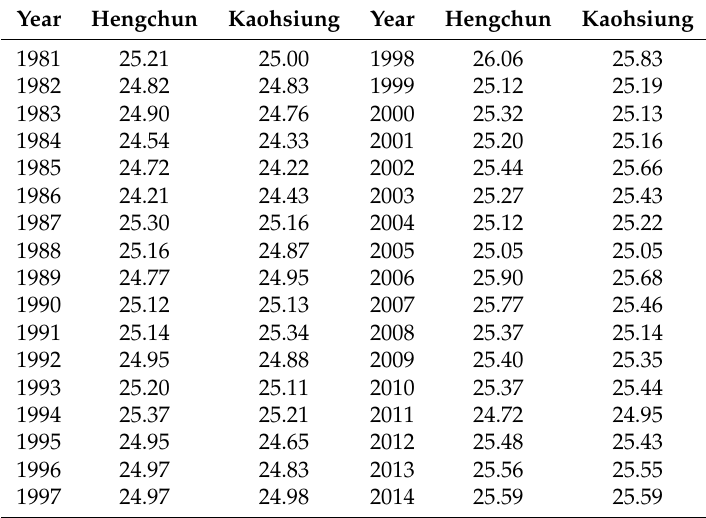
Table 3. Temperature records ( ◦ C) at Hengchun and Kaohsiung